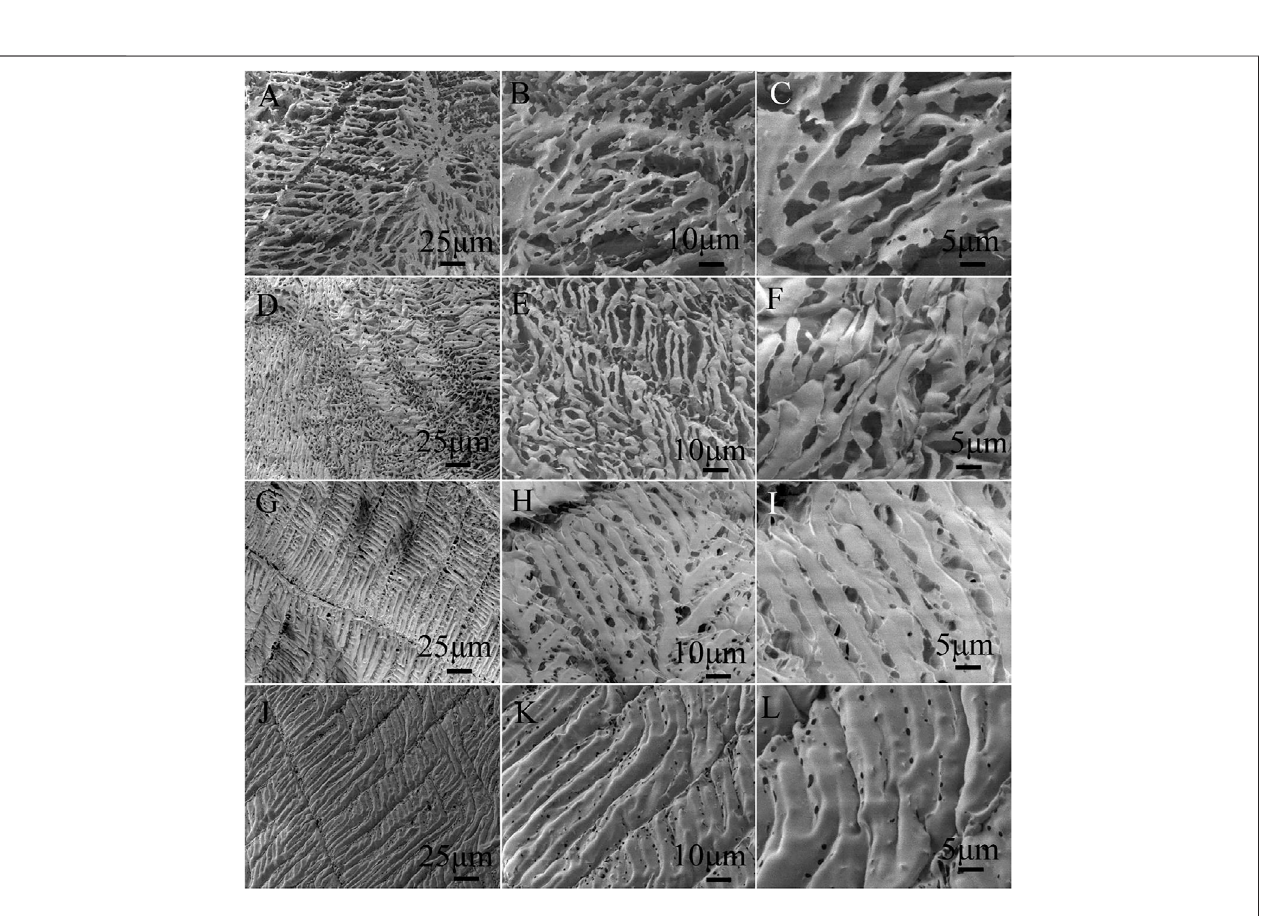
FIGURE 2 | SEM images of freeze-dried HPAM (n AM /n AA (cid:2) 9/1) (A,B,C) , z-HPAM (n AM /n AA /n MDSA (cid:2) 9/1/1) (D,E,F) , p-HPAM (n AM /n AA /n PEGMA (cid:2) 9/1/0.14) (G,H,I) , and zp-HPAM (n AM /n AA /n MDSA /n PEGMA (cid:2) 9/1/1/0.14) (J,K,L)